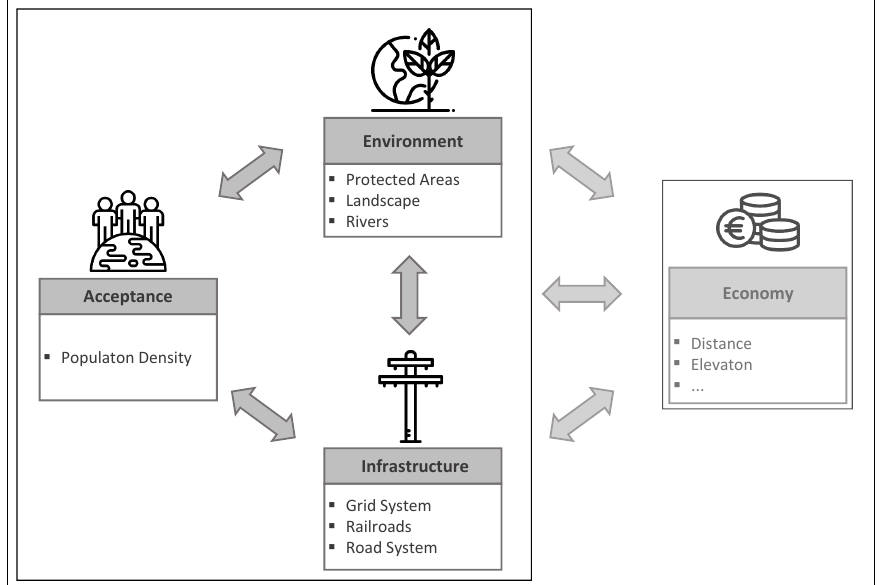
Figure 1. Provided dimensions and related criteria. Own